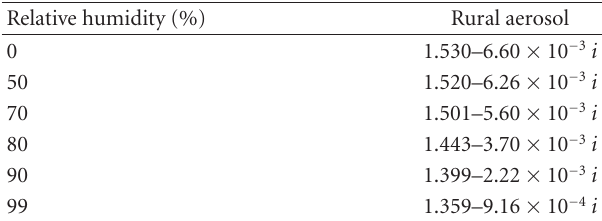
Table 1: Refractive Index of Atmospheric Aerosol Particle at a He-Ne Laser Wavelength (0.6328 μ m) for Rural Aerosol Model (according to Kim and Boatman,